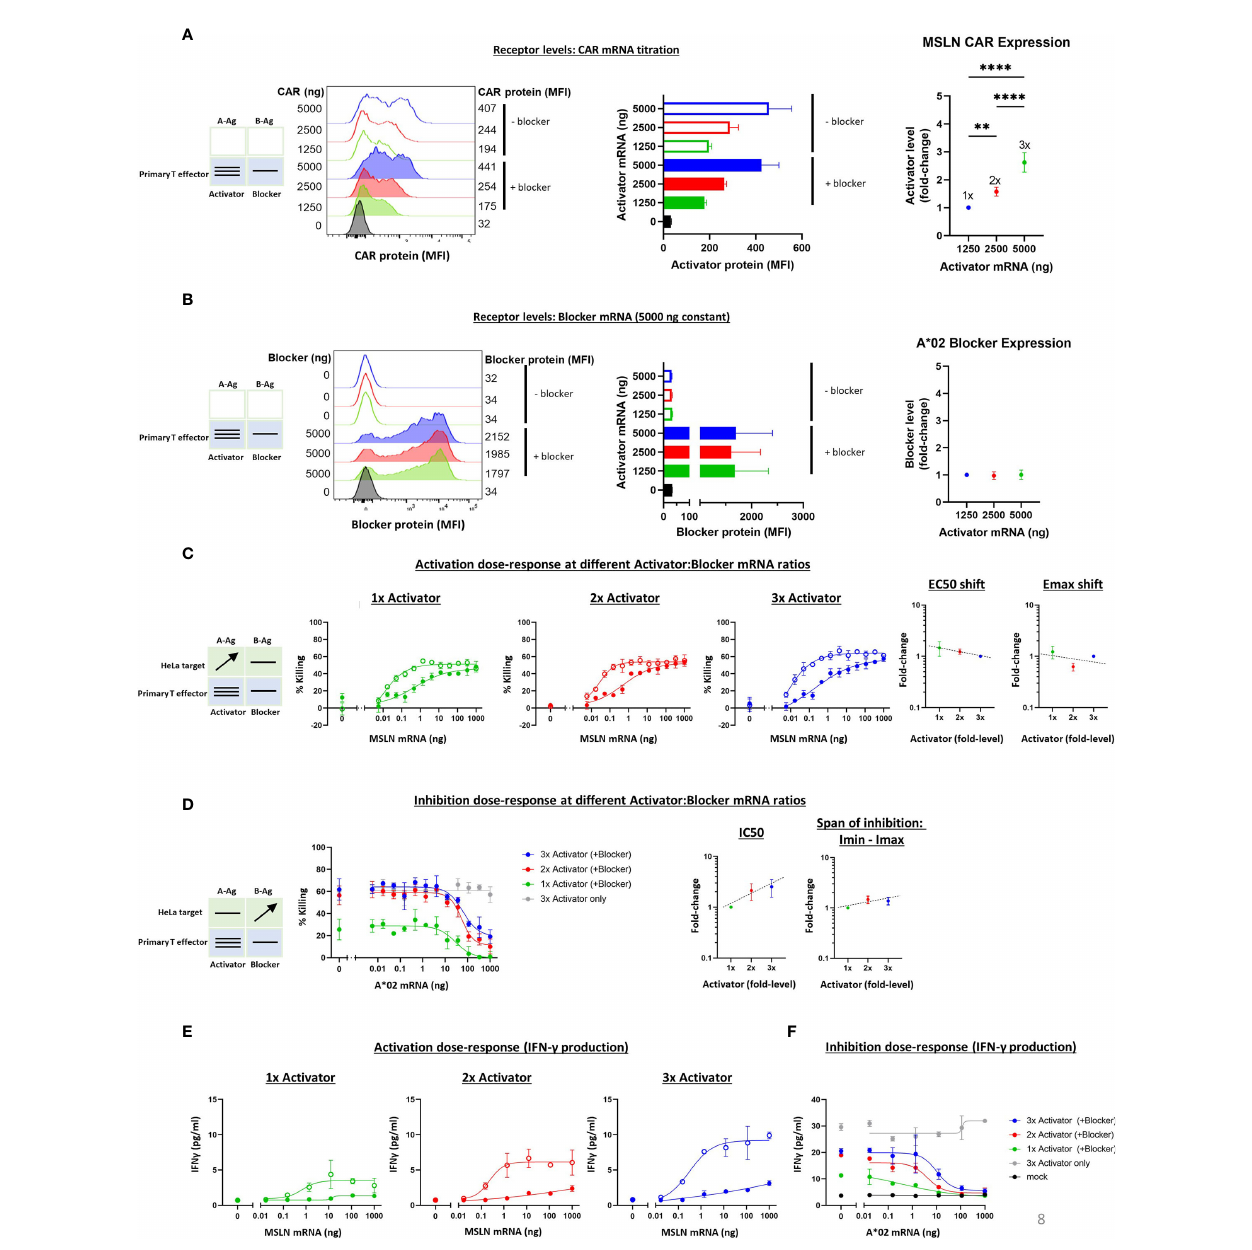
FIGURE 7 | Altering the ratio of MSLN CAR activator to A*02 blocker in primary T effector cells (Donor 1). Cell surface staining of activator and blocker receptors vs. various MSLN CAR mRNA amounts, analyzed by fl ow cytometry. Blocker was held constant at 5000 ng mRNA and activator (MSLN CAR) was varied at 0, 1250, 2500 and 5000 ng as shown. (A) MSLN CAR and A*02 blocker. MSLN CAR was stained with labeled MSLN tetramer (see Methods ). To calculate fold-expression, background was subtracted before normalization to the lowest value. Bar chart colors match fl ow histogram colors. (B) Blocker protein level is minimally affected by varying activator level. Surface expression of blocker at different mRNA amounts of CAR activator. Blocker was stained with A*02 pMHC tetramer (see Methods ). Fold-changes shown on graphs (i.e., 1x, 2x, 3x) are based on surface protein estimates, not mRNA amount. MFI, geometric mean fl uorescence intensity. (C) Activation (killing of GFP-labeled target cells) response to varied ratios of MSLN CAR to A*02 blocker after 12 hours of co-culture with target cells. Activation dose- response curves are shown for each ratio of CAR to blocker tested. Open circles = CAR only, fi lled circles = CAR + blocker. MSLN knockout HeLa cells (GFP- labeled) provided the stimulus. MSLN A-Ag levels were varied with constant B-Ag (50 ng A*02 mRNA, ~58,000 molecules/cell). Shifting of EC50 and Emax with blocker present is shown for each activator amount. (D) Inhibition response to varied MSLN CAR to A*02 blocker ratios after 12 hours of co-culture with target cells. Wildtype HeLa cells (GFP-labeled) provided the A-Ag stimulus (endogenously expressed ~50,000 MSLN molecules/cell), and B-Ag (A*02 mRNA) was varied. Dashed lines are meant to convey trends and are not fi t mathematically. (E, F) IFN g release by primary T cells after 24 hours of co-culture for each ratio of CAR to blocker tested. *p<0.05, **p < 0.01, ***p < 0.001, ****p < 0.0001, n =